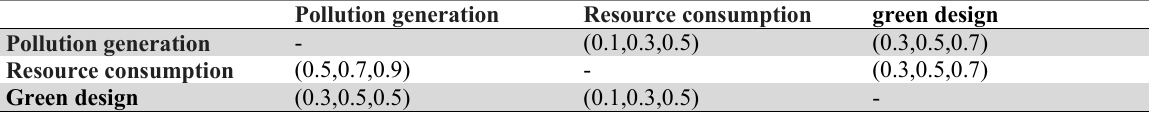
The relative importance of environmental benefits criteria when an environmental management system is under control